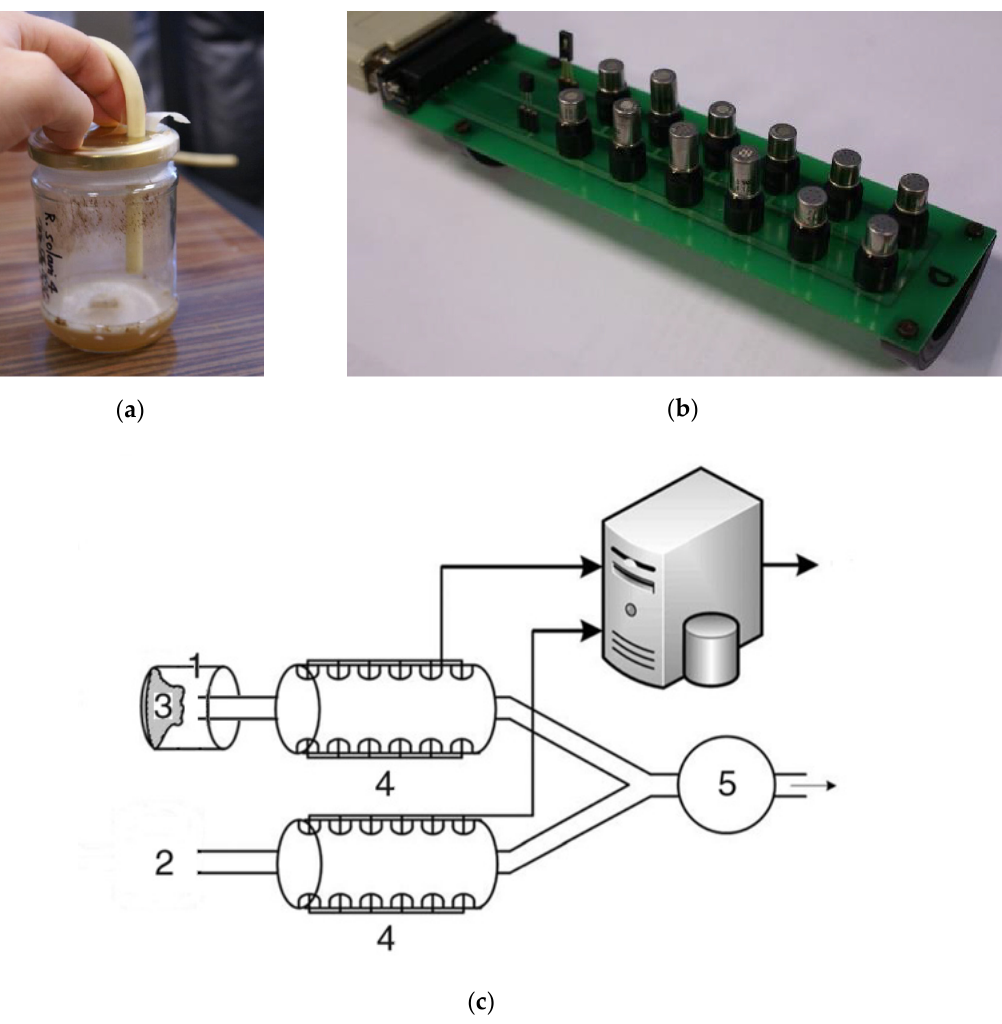
Figure 3. Representative view of the differential electronic nose apparatus. ( a ) Introduction of the air intake tube inside the sample; ( b ) Twelve chemical sensors in an array chamber; ( c ) General scheme of the e-nose principle of measurement: (1) Sample flask; (2) Ambient air; (3) Tested material; (4) Sensor chambers; (5) Inducting pump and flow-meter. Adapted from Brudzewski et al. [22], Osowski et al. [114].